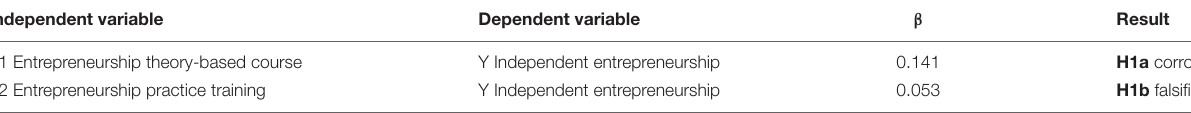
TABLE 6 | Parameters for main effect test.